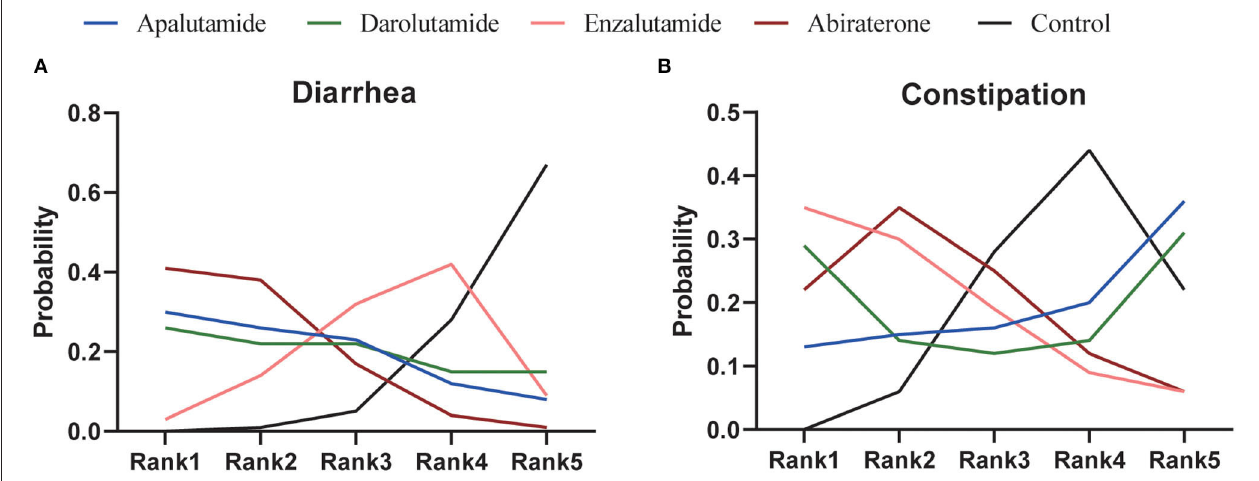
FIGURE 4 | Ranking of treatments in terms of diarrhea (A) and constipation (B) .